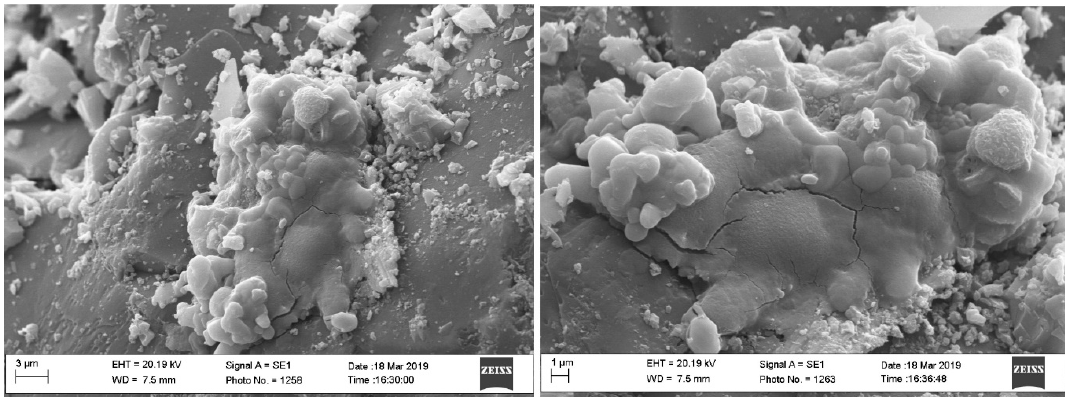
Figure 9. Quartz, 220 MPa: amorphous silica extruded from a fracture on quartz surface.